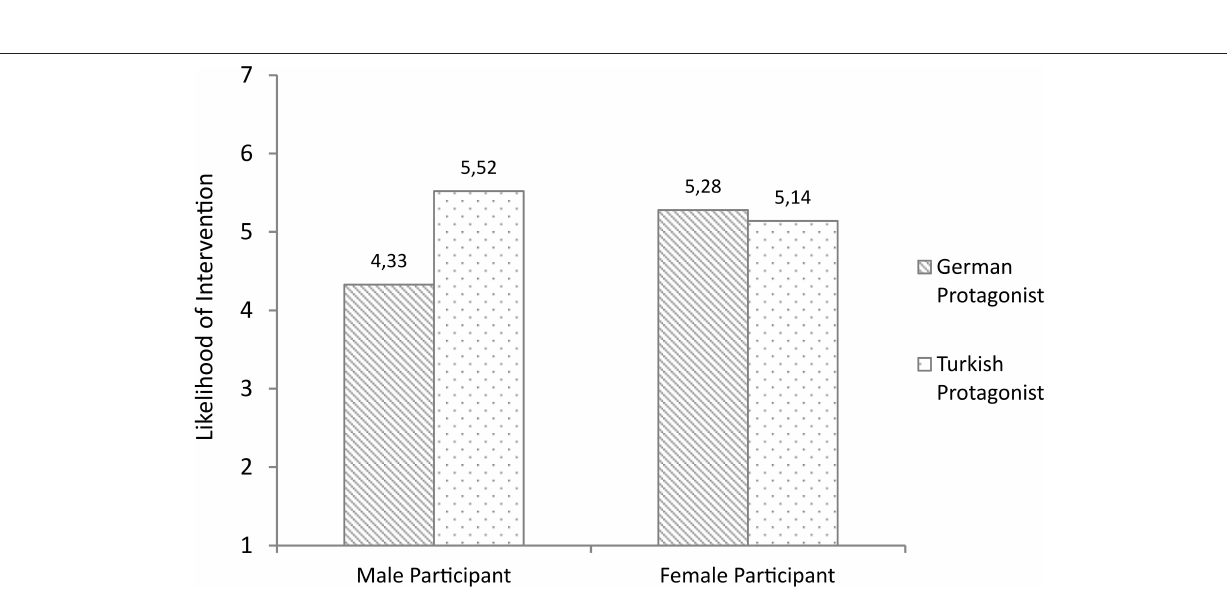
significant interaction effect of justification and the protagonist, F (2.50, 342.96) = 3.02, p = 0.039, η p2 = 0.02. This